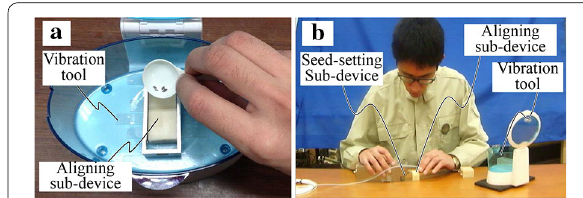
Fig. 20 a Aligning sub-device in the vibration tool. b Scenes in the motion simulation of the seed-aligning